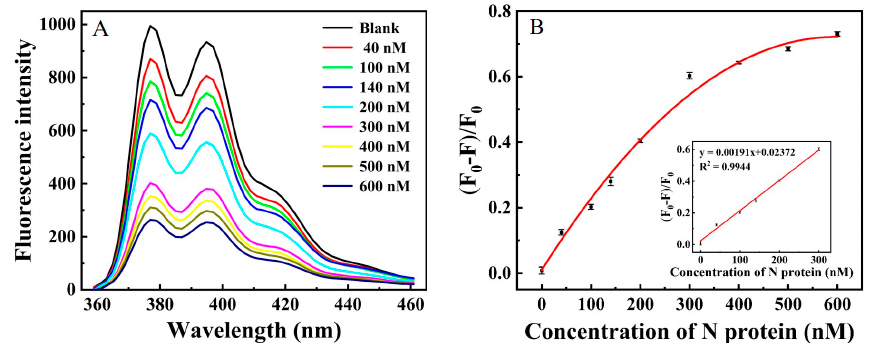
Figure 6. ( A ) Fluorescence emission spectra of the system under the concentration of N protein from 0 to 600 nM. ( B ) The linear relationship between the concentration of N protein (the concentration from left to right was 0, 40, 100, 140, 200, and 300 nM, respectively) and (F 0 − F)/F 0 (S/N = 3). The concentration of aptamer, Exo I, and β -CDP was 400 nM, 240 U/mL, and 1.5 mg/mL, respectively. The excitation wavelength was set at 345 nm, and the maximum emission wavelength was set at 376 nm.